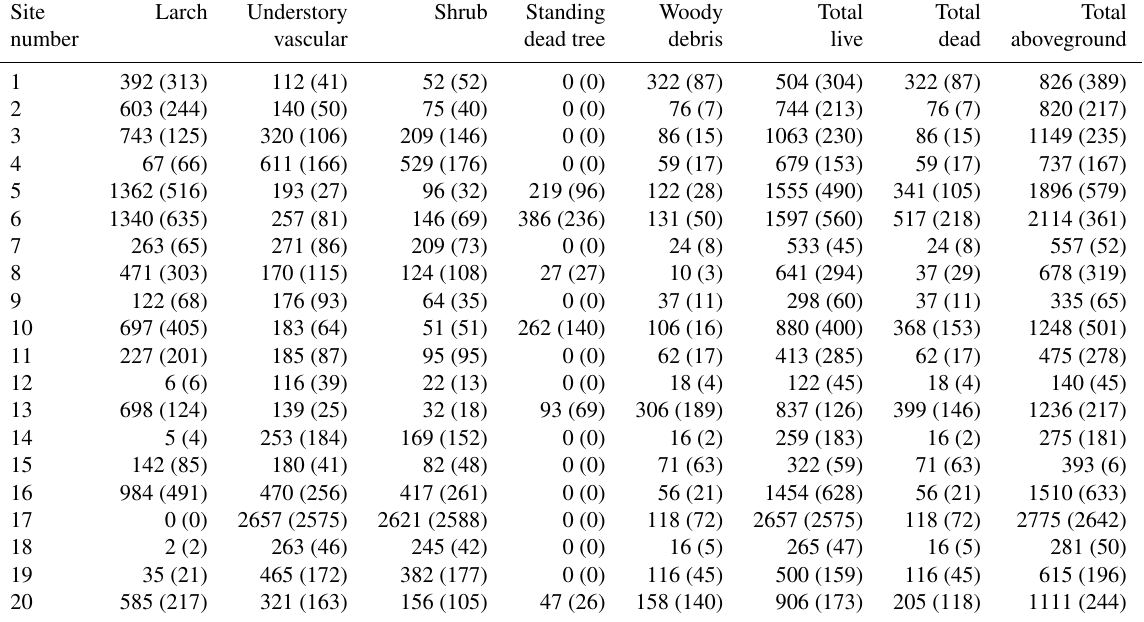
Table 3. Aboveground biomass (gCm − 2 ) at each site in the Y4 watershed. Total aboveground biomass is the sum of the larch, understory vascular, standing dead tree, and woody debris biomass. Understory vascular biomass does not include lichen and moss. Values in parentheses are standard error of the